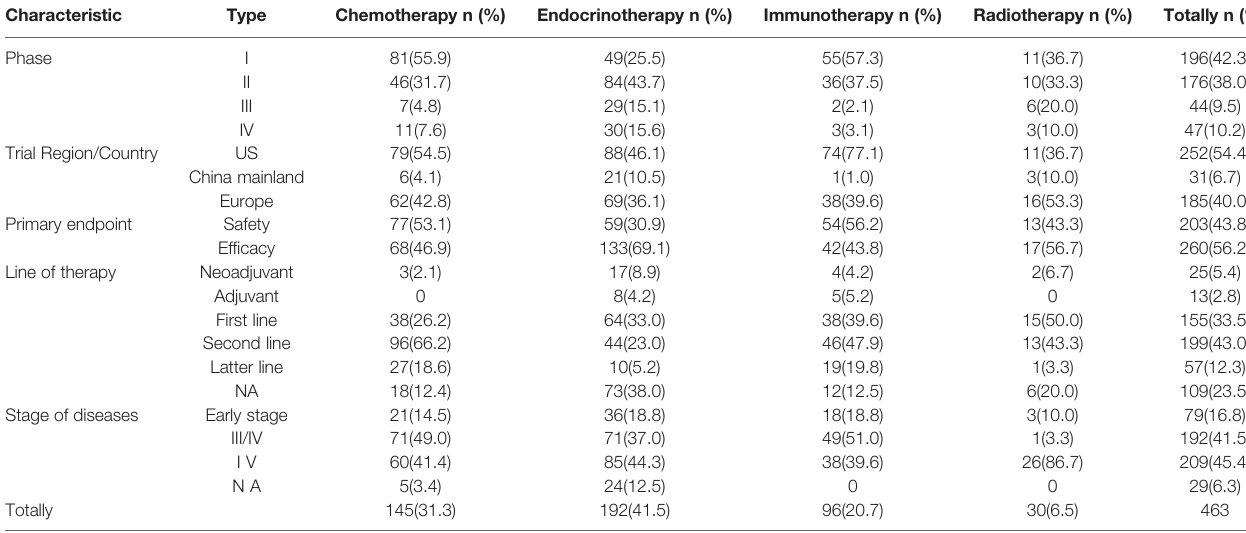
Phase: I, I/II, and II are early stage clinical trials. Trial region/country: The region or country covered by clinical trials. NA, Not applicable.